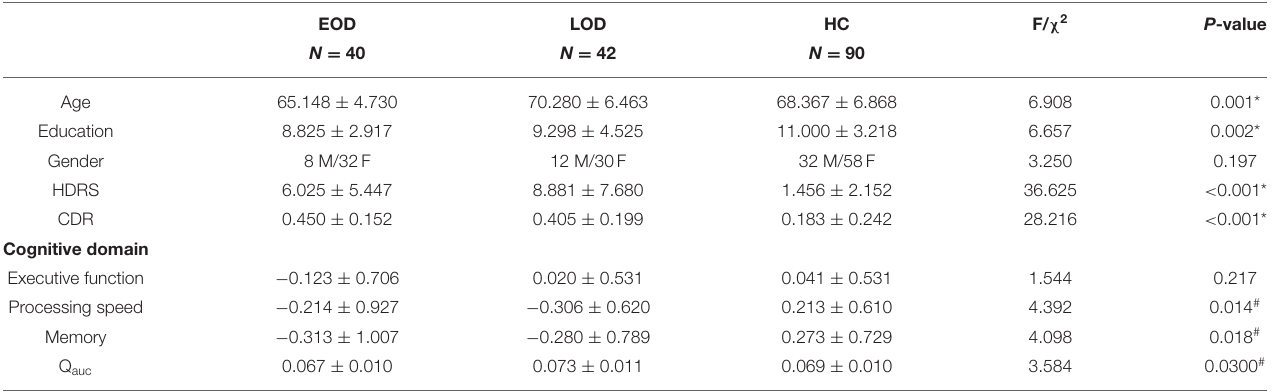
TABLE 1 | The comparison of demographic, cognitive functions and modularity between groups.